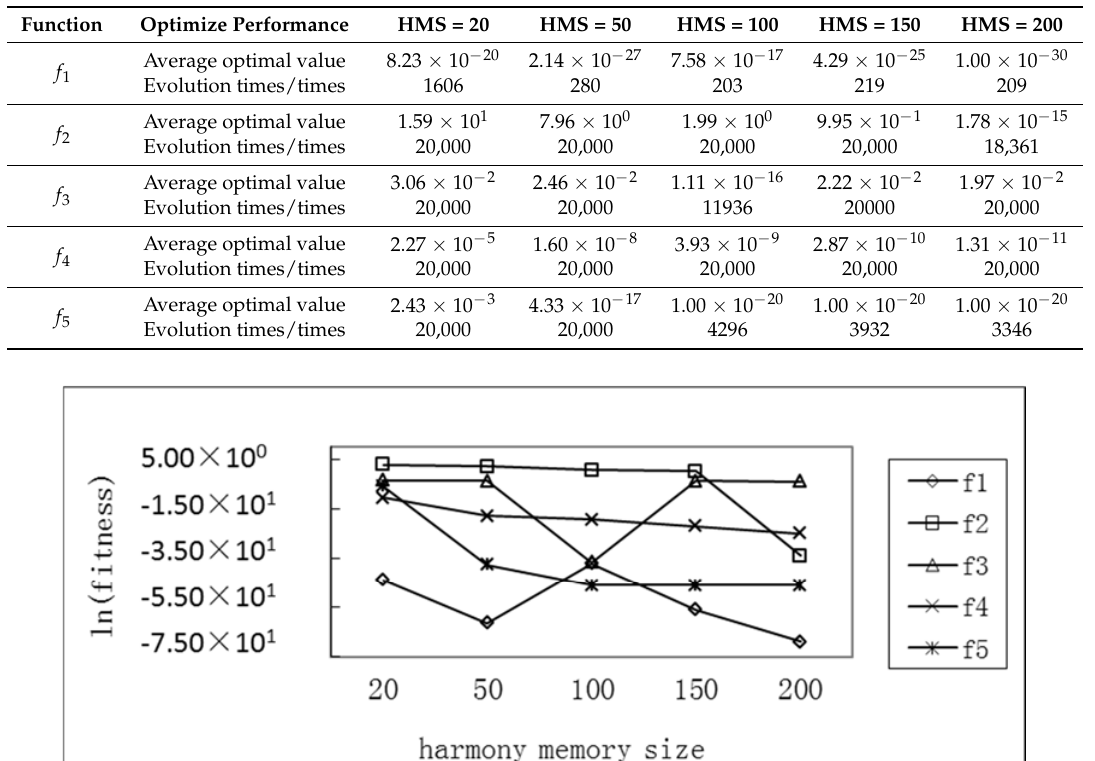
Table 6. Comparisons of the convergence performance with different harmony memory sizes of the SC-AHS algorithm.